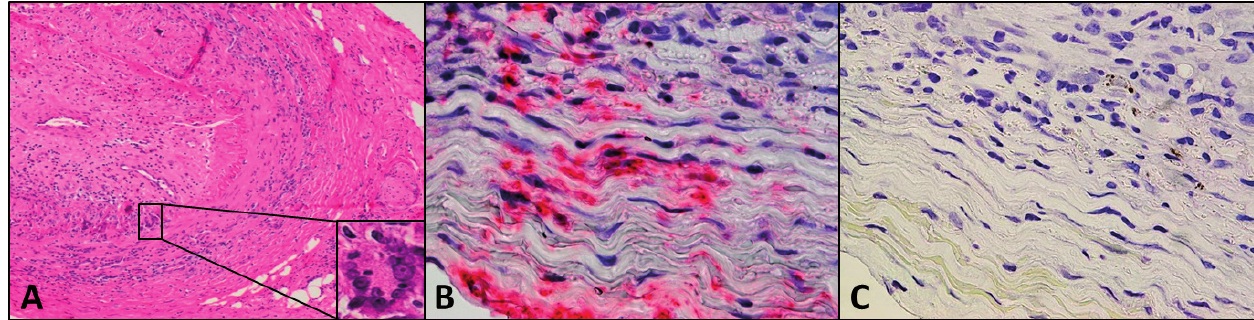
Figure 1. Detection of varicella zoster virus (VZV) antigen in the temporal artery of a patient with giant cell arteritis. Hematoxylin- and-eosin staining of the temporal artery from a 90-year-old man with classic giant cell arteritis ( A ). Note extensive inflammation in the adventitia, media and intima, disruption of the media, a thickened intima, and nearly occluded arterial lumen; inset denotes a giant cell. Immunohistochemical staining with mouse anti-VZV gE antibody revealed VZV antigen (red) in the adventitia and media of the temporal artery ( B ) that was not seen when mouse isotype IgG1 antibody was substituted for mouse anti-VZV gE antibody ( C